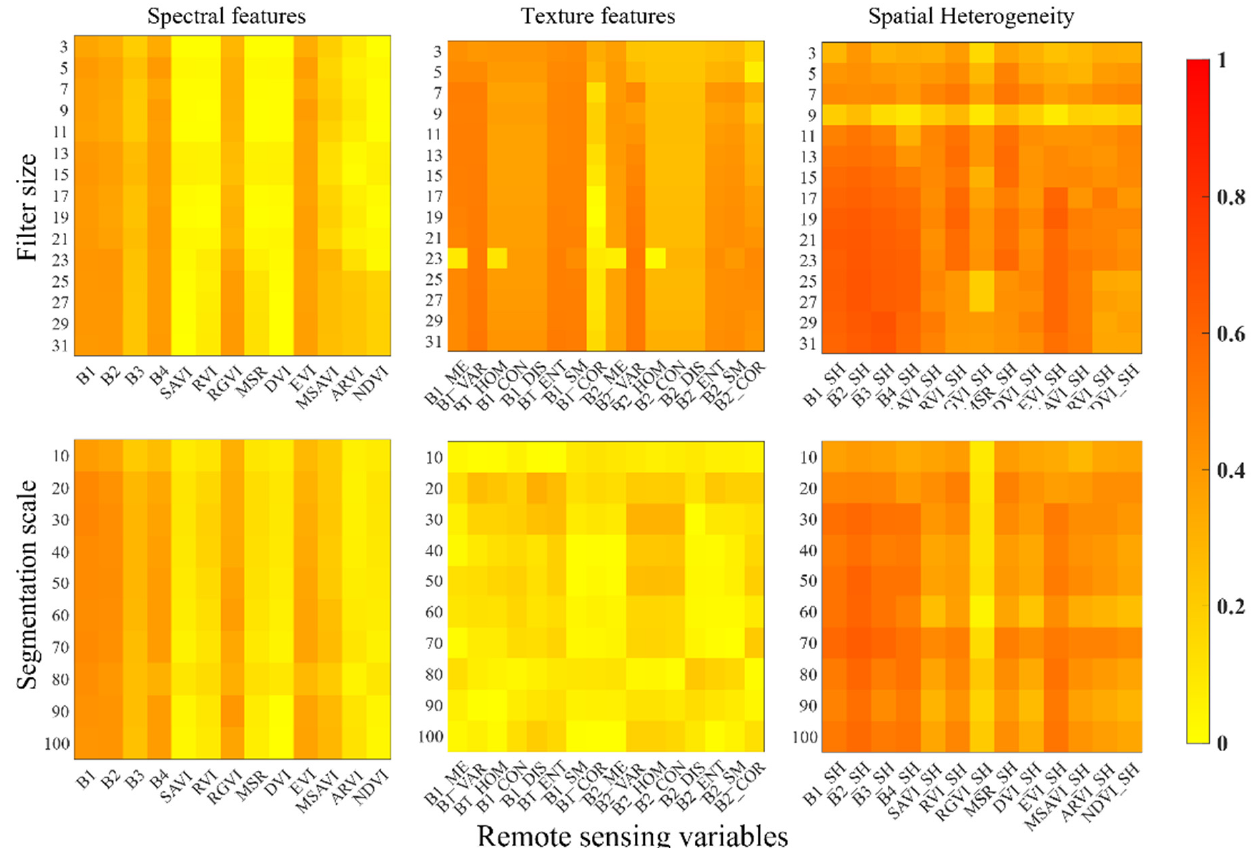
Figure 9. Pearson correlations between tree CDs and various types of variables.